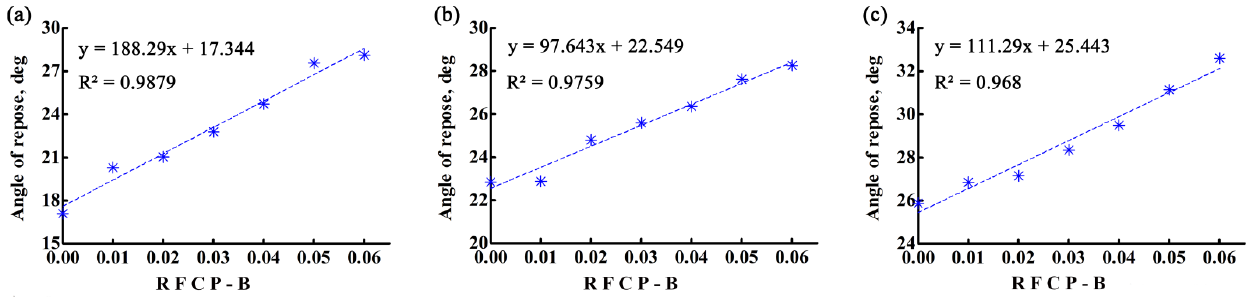
Figure 16. The relationship between the angle of repose and the RFCP-B for ( a ) SN42, ( b ) JD17, and ( c ) ZD39. ( c )